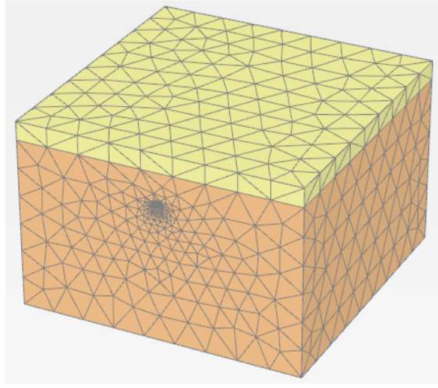
Figure 5. Modelling and mesh in numerical analysis.